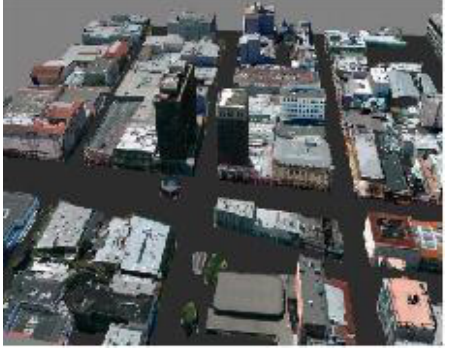
Fig.15- 3D model of area (source - Früh and Zakhor,